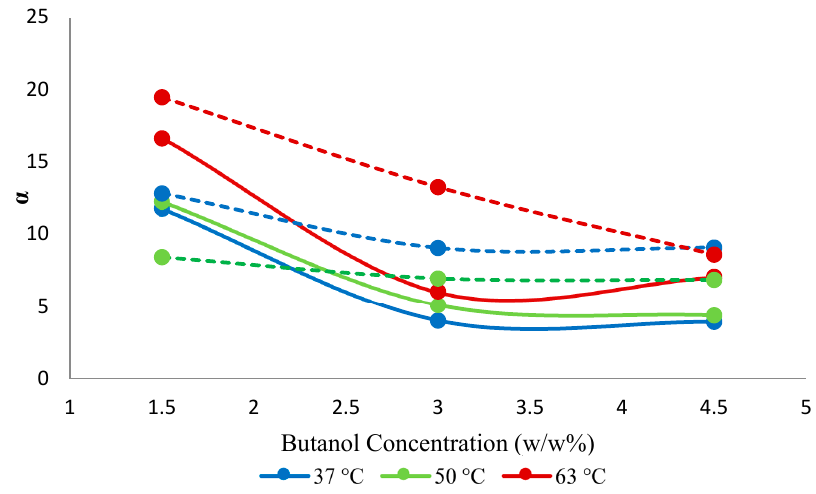
Figure 9. Effect of feed concentration on selectivity ( α ) against temperature. Solid lines represent hybrid PTMSP membrane and dotted lines represent a neat PTMSP membrane. Data for pure PTMSP were taken from the literature [26].